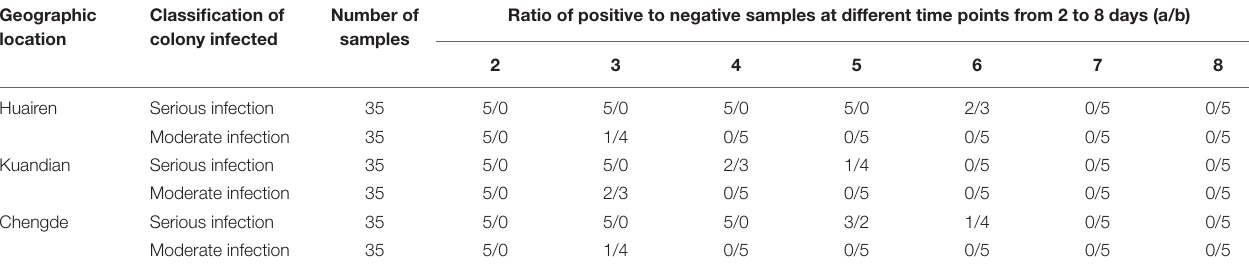
a and b represent the number of positive and negative samples for detecting CSBV by RT-PCR, respectively. Number of sample 35 means that 5 A. cerana larvae were randomly selected on 2, 3, 4, 5, 6, 7, and 8 days after treatment.